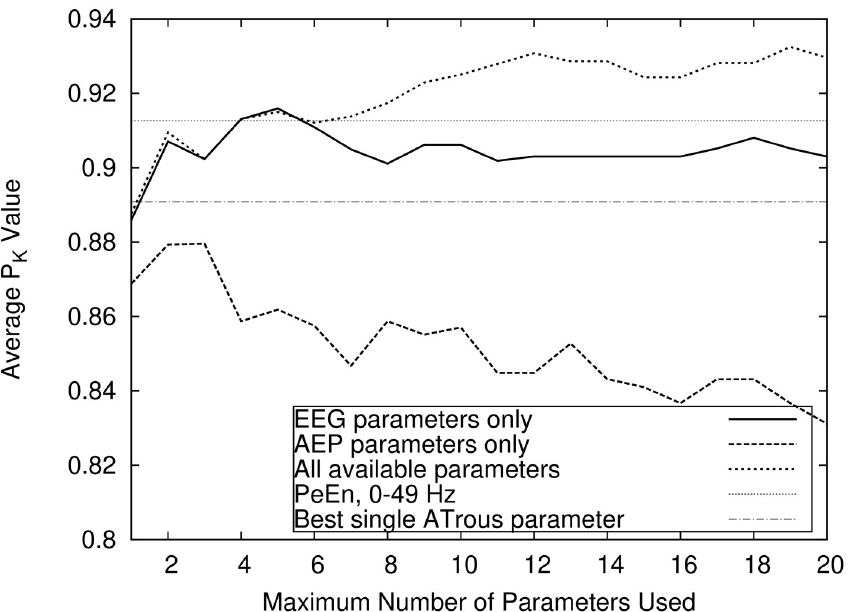
Fig 3. Pure EEG vs pure AEP indicators. Comparison of the prediction performances using the RBF-Kernel SVM reached by allowing only either EEG or AEP parameters, or combinations of both. The single EEG and AEP parameters with the highest P K are shown for comparison.